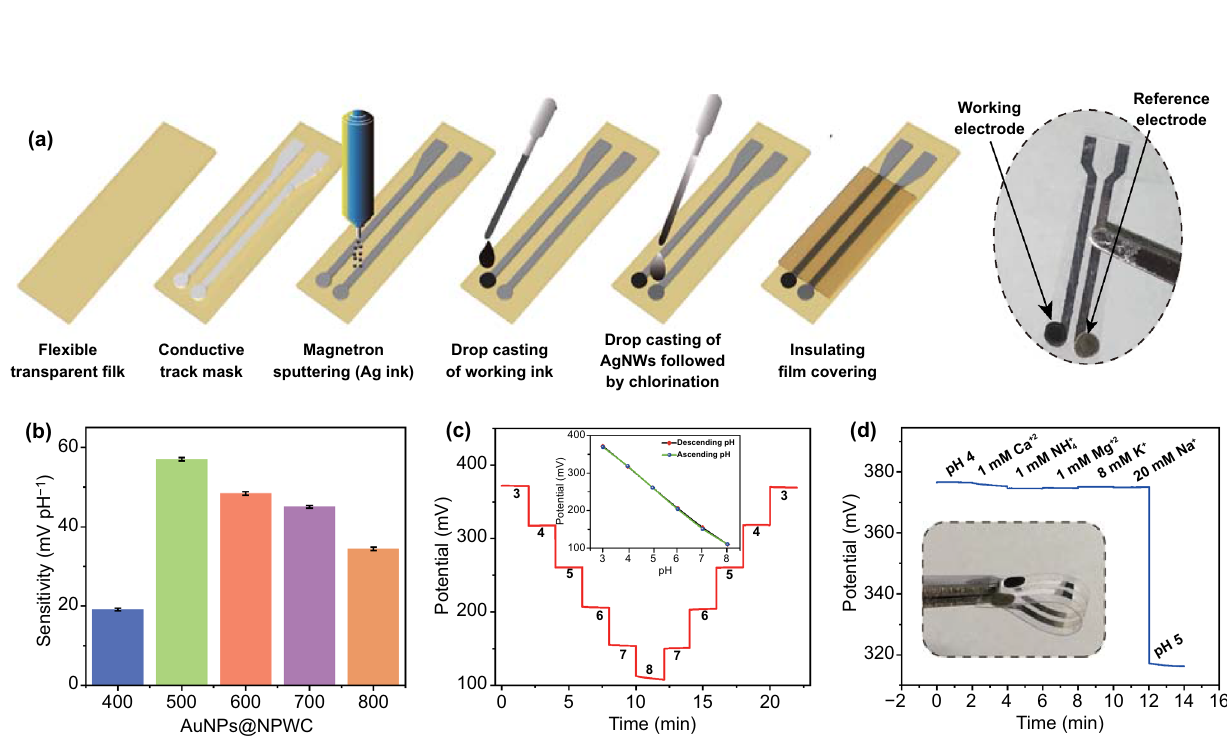
Fig. 4 General strategy and response of pH sensor: a Fabrication of two electrode strip-based flexible sensor, b pH sensitivity of carbonized composite materials, c repeatability analysis and d selectivity of AuNPs@NPWC-500 modified pH sensor (inset showing hysteresis